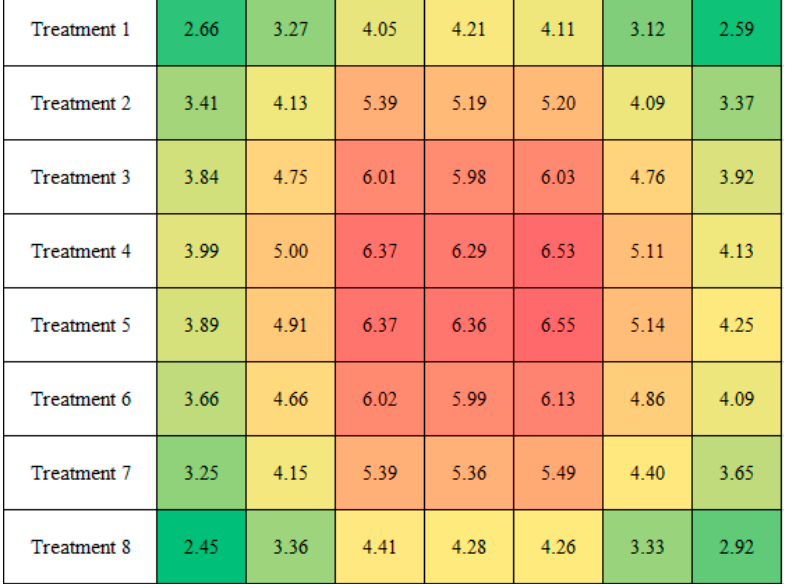
Figure A5. Map of UV light intensity (irradiance) measurements for UV − C (254 nm) for Treatment 1 to Treatment 8. Each colored grid represents an approximately ~4 × 4 cm area where the UV sensor was in place for measurement. The color gradient green − yellow − red represents increasing UV light intensity. Units: mW/cm 2 .